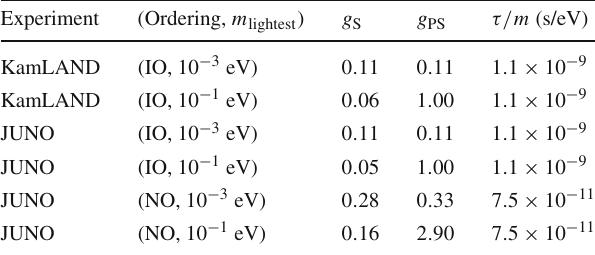
Table 2 The 90% CL upper bound on the couplings and the lower Table 3 The 90% CL lower bound on the lifetime/mass of active neu- boundonthelifetimeofactiveneutrinosforthegivenmassorderingand trinos for the given mass ordering and the values of the lightest neutrino the values of the lightest neutrino mass, obtained through the sensitivity mass,obtainedthroughthesensitivityanalysesoftheexperimentsKam- analyses of the experiments KamLAND and JUNO. The values of g S LAND and JUNO. The values of τ/ m = τ 3 / m 3 ( τ 2 / m 2 ) for the normal (inverted) ordering, calculated for a given m lightest , shown correspond and g PS shown correspond to (cid:7)χ 2 = 4 . 61 for 2 DOF. The value of τ/ m shown is calculated for the given m to (cid:7)χ 2 = 2 . 71 for 1 lightest and the obtained value of g S again for 2 DOF Experiment